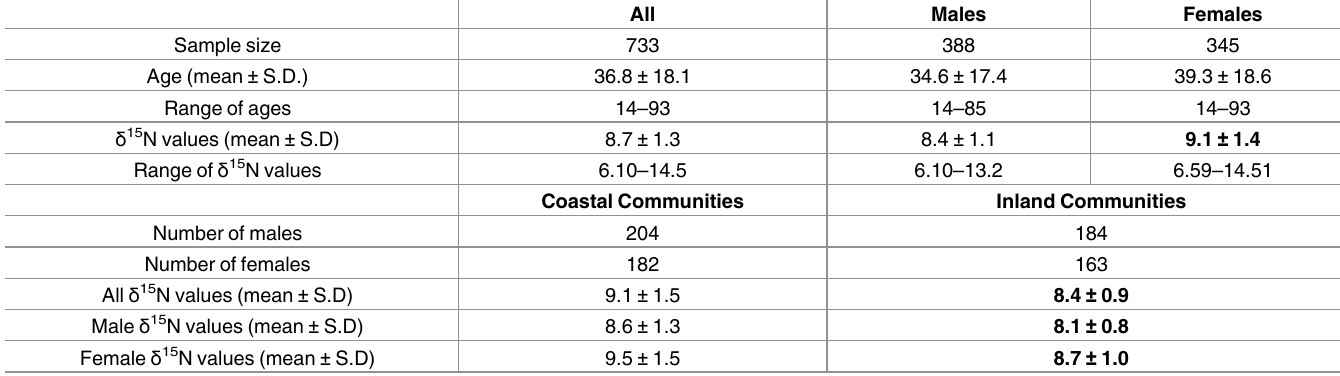
Table 1. Demographic characteristics of the Yup’ik study participants and descriptive statistics for the δ 15 N value.